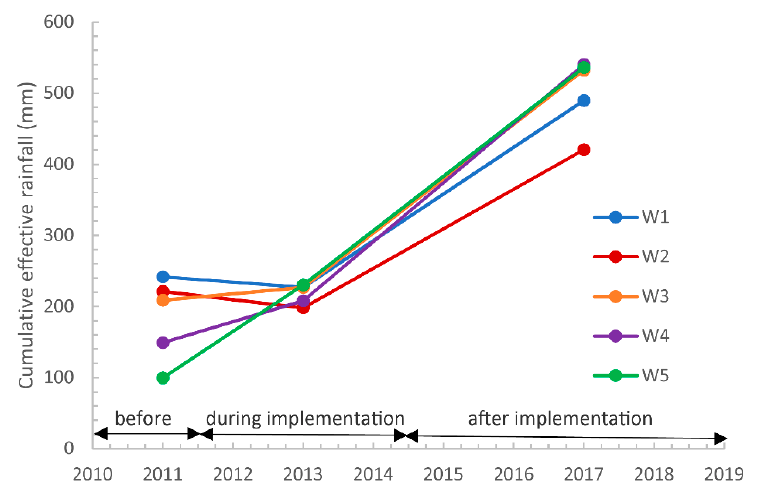
Figure 7. Average cumulative rainfall required to generate greater or equal to 3 mm runoff before